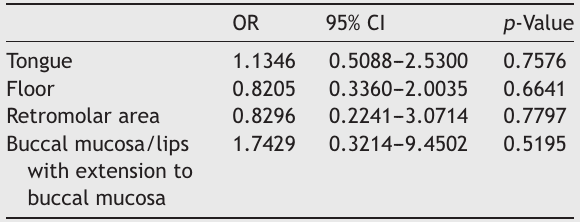
Odds ratio, confidence interval and p -value according to oral cavity